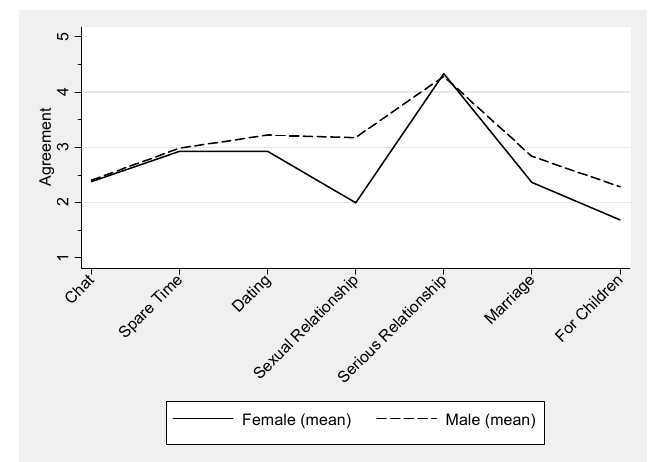
Figure 8 : Profile plot of reasons for using online dating